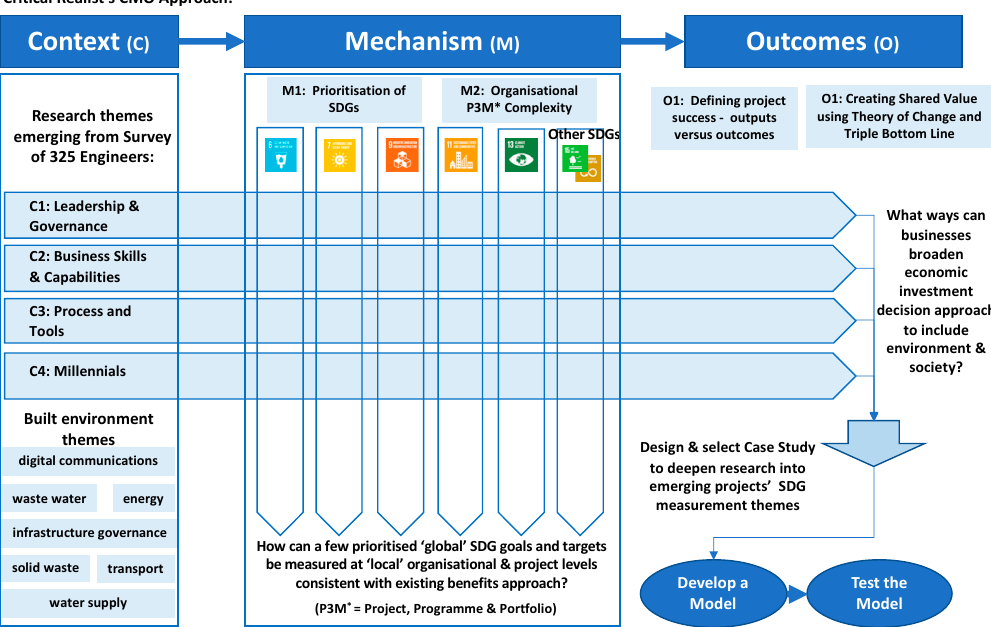
Figure 17. Conceptual framework for next phase of research using the critical realist Context–Mechanism–Outcome Approach for future qualitative investigation of forty senior executive interviews.